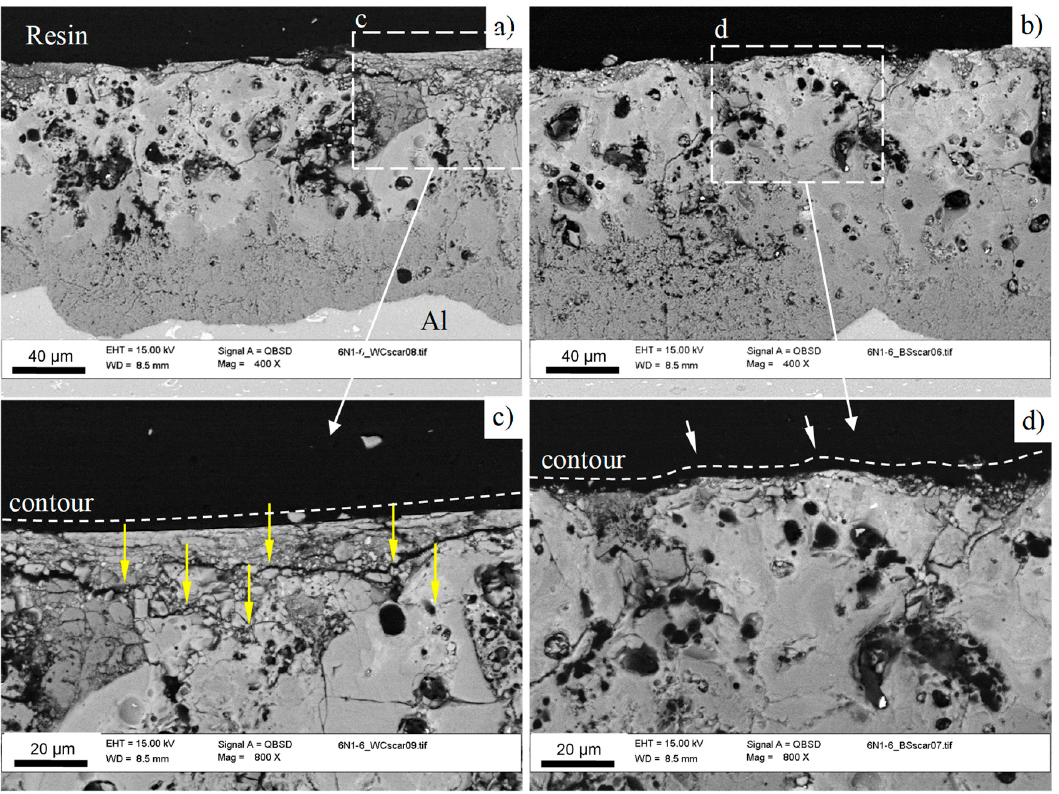
Figure 12. Cross sectional SEM BSE images of the bottom of the wear scars on the PEO coatings tested against different counterfaces of ( a , c ) WC-4%Co and ( b , d ) bearing steel. Yellow arrows denote delamination cracks.